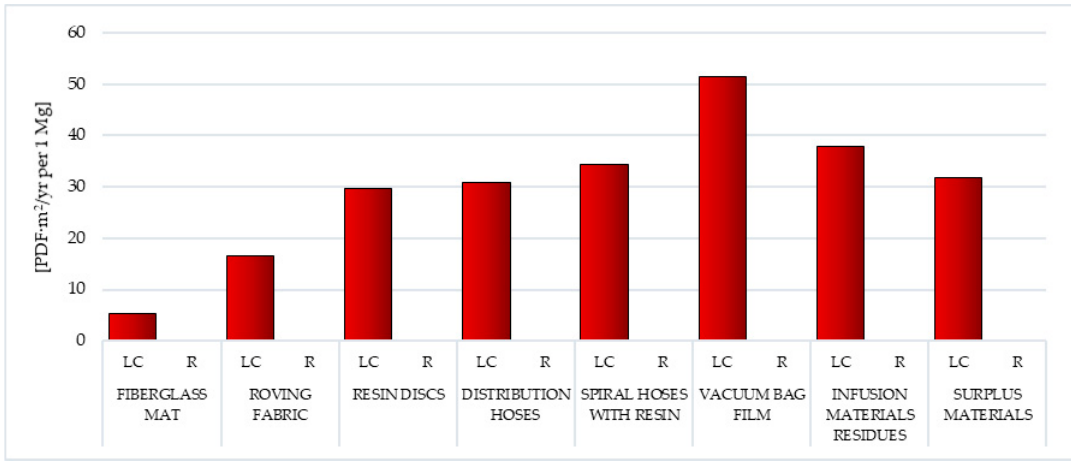
Figure 12. Characterization results of environmental consequences for processes related to land use, present in selected postproduction waste of wind power plant blades: LC—life cycle, R—recycling [unit: PDF·m 2 /yr per 1 mg].